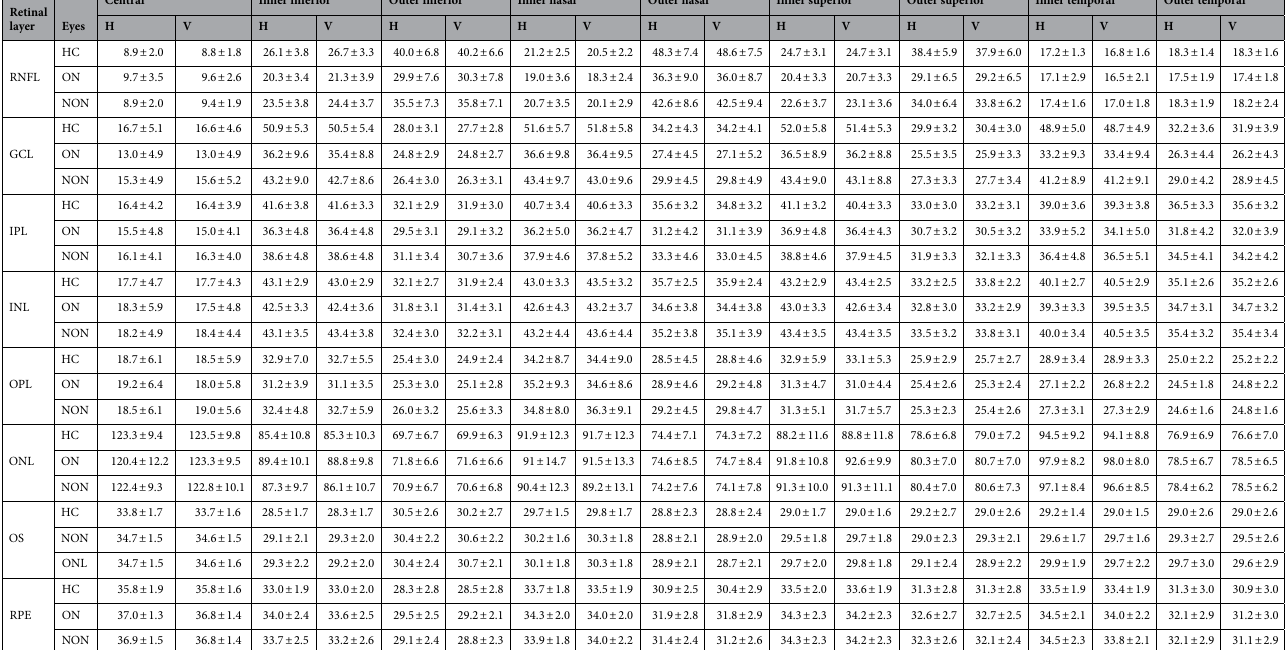
Table 1. Average thickness values for eight layers in nine early treatment diabetic retinopathy study sectors for the three groups. All values are expressed in microns. HC healthy controls, ON eyes with optic neuritis, NON fellow eyes without optic neuritis, H horizontal scan, V vertical scan, RNFL retinal nerve fiber layer, GCL ganglion cell layer, IPL inner plexiform layer, INL inner nuclear layer, OPL outer plexiform layer, ONL outer nuclear layer, OS outer segment, RPE retinal pigment